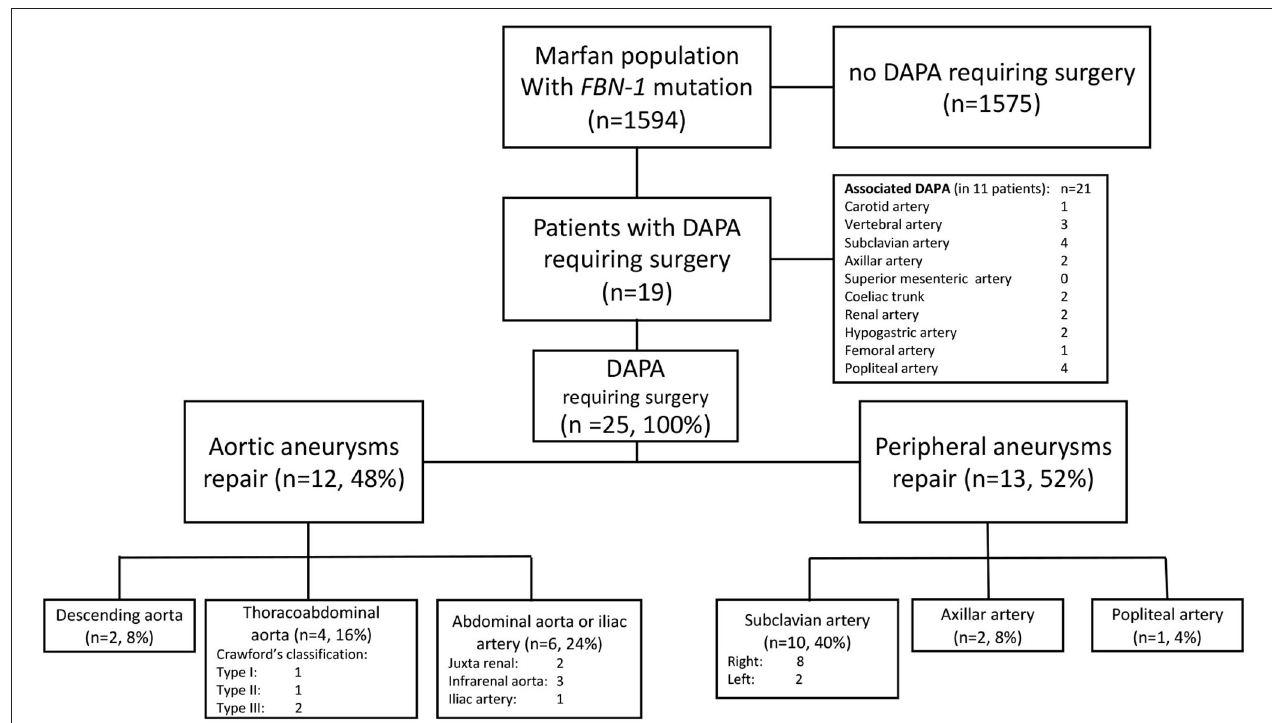
FIGURE 1 | Characteristics of aneurysms in the study group ( n = 25 aneurysms).